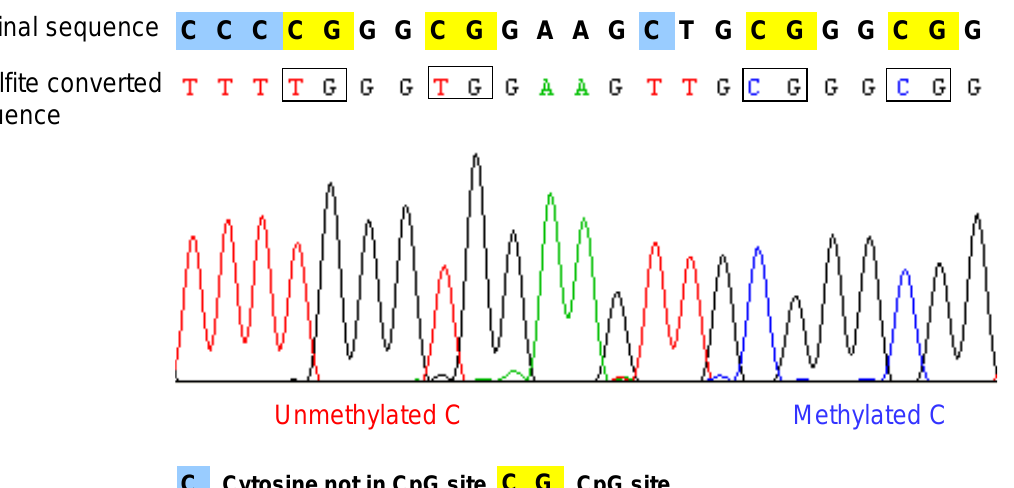
cytosine and unmethylated cytosine can be distinguished according to the sequencing result. Original sequence: DNA sequence before bisulfite